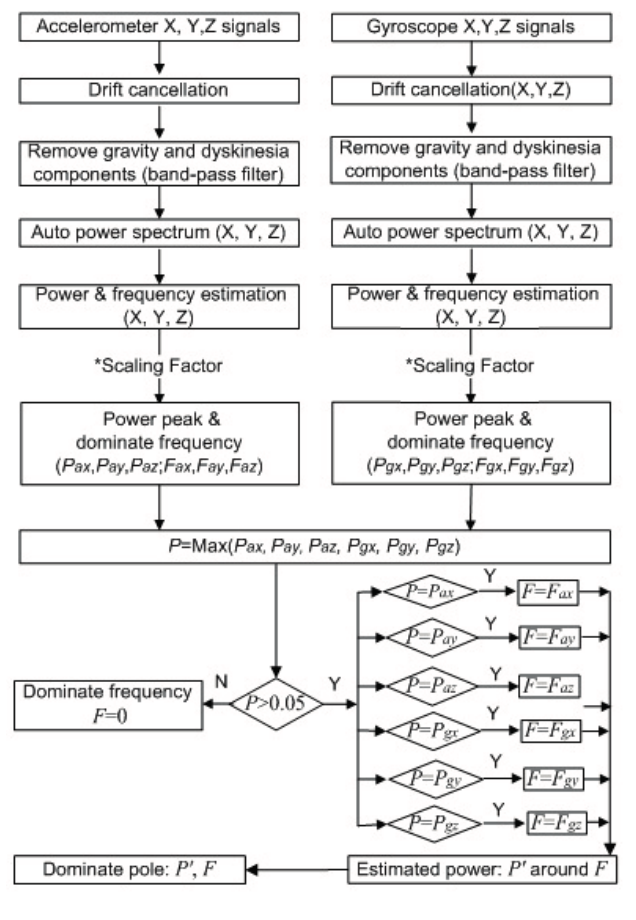
Figure 4. Signal processing for the tremor detection and quantification (six